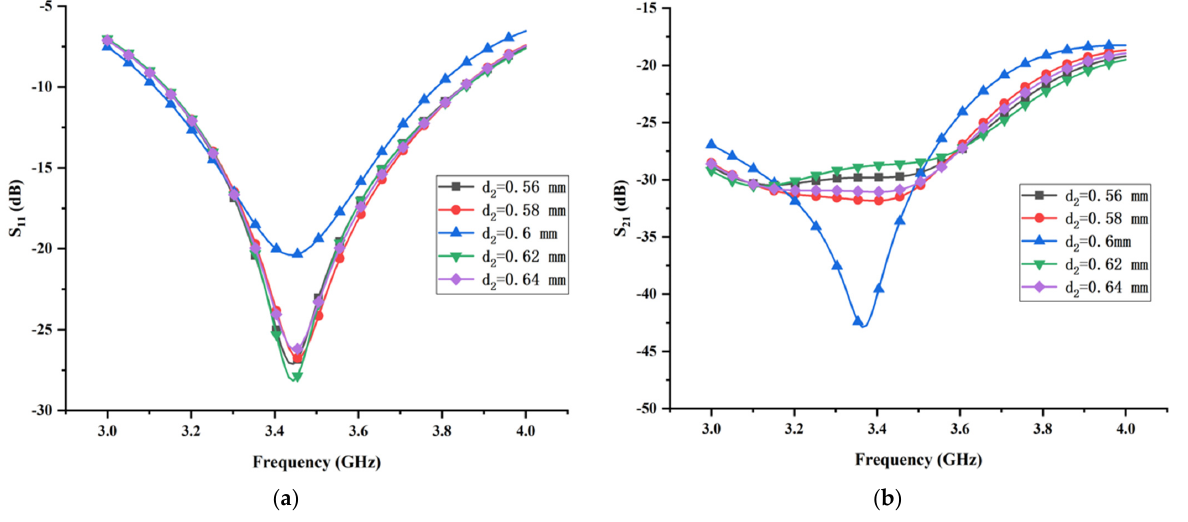
Figure 12. The effects of the diameters d 2 of the metallic vias on ( a ) reflection coefficient and ( b ) transmission coefficient.